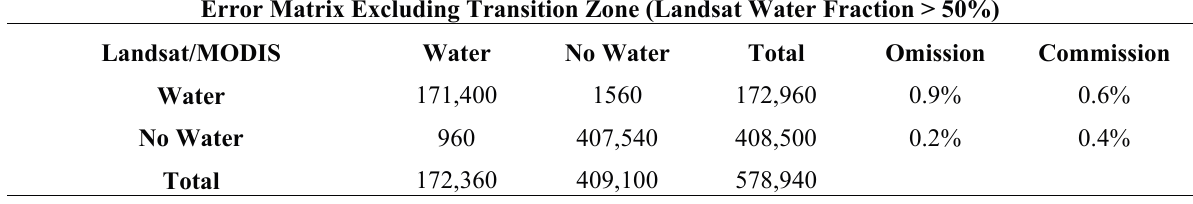
Error Matrix taking the transition zone into account (Landsat fraction < 50%)